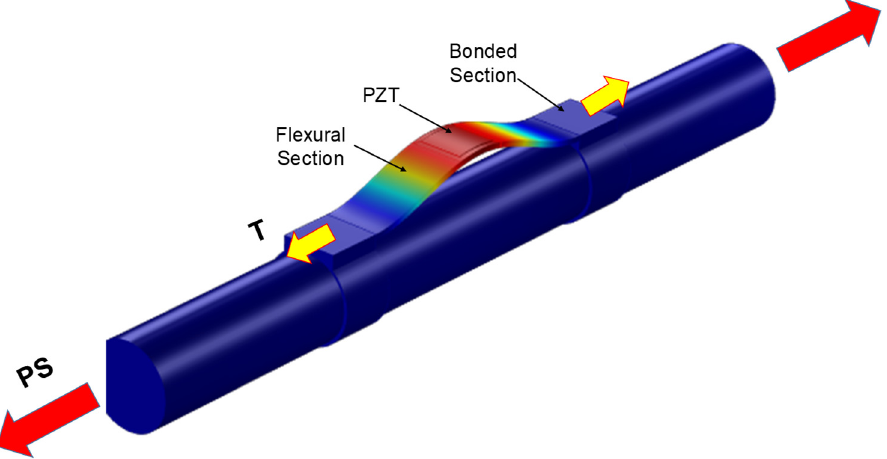
Figure 3. The 1st bending deformation of the EMI sensor due to the piezoelectric effects. The interaction between the PZT and the substrate structure can be theoretically described by a simplified EMI model, as depicted in Figure 4. Under the effect of applied voltage V, the PZT is expanded and its deformation drives the substrate structure through the contact force F. The ability to resist this piezoelectric deformation is regarded as the mechanical impedance of the structure, which can be computed as the rate between the exciting force F and the velocity v s at the PZT driving point, as follows [45]: